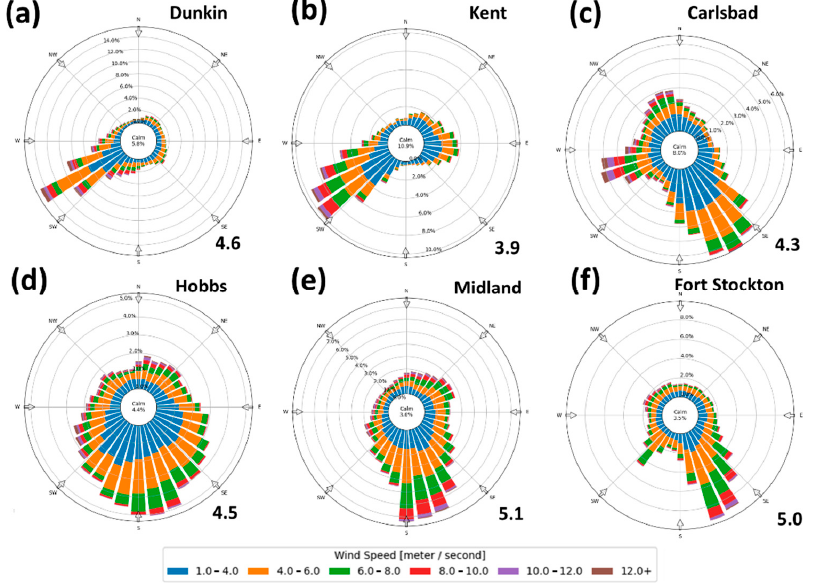
Figure 8. Ten-meter wind rose plots for the six weather stations shown in Figure 1 and listed in Table 1 for the 24-month period 1 December 2018–1 December 2020: ( a ) Dunkin, New Mexico; ( b ) Kent, Texas; ( c ) Carlsbad, New Mexico; ( d ) Hobbs, New Mexico; ( e ) Midland, Texas; and ( f ) Fort Stockton, Texas. Calm wind observations are noted in the center of the wind rose, and the mean wind speed (in meters per second) at each of the six stations is shown in the lower right corner of each plot. The frequency of winds observed from each direction is shown by the location on the wind rose, while the wind speed associated with that direction is shown according to the speed color scale listed above.